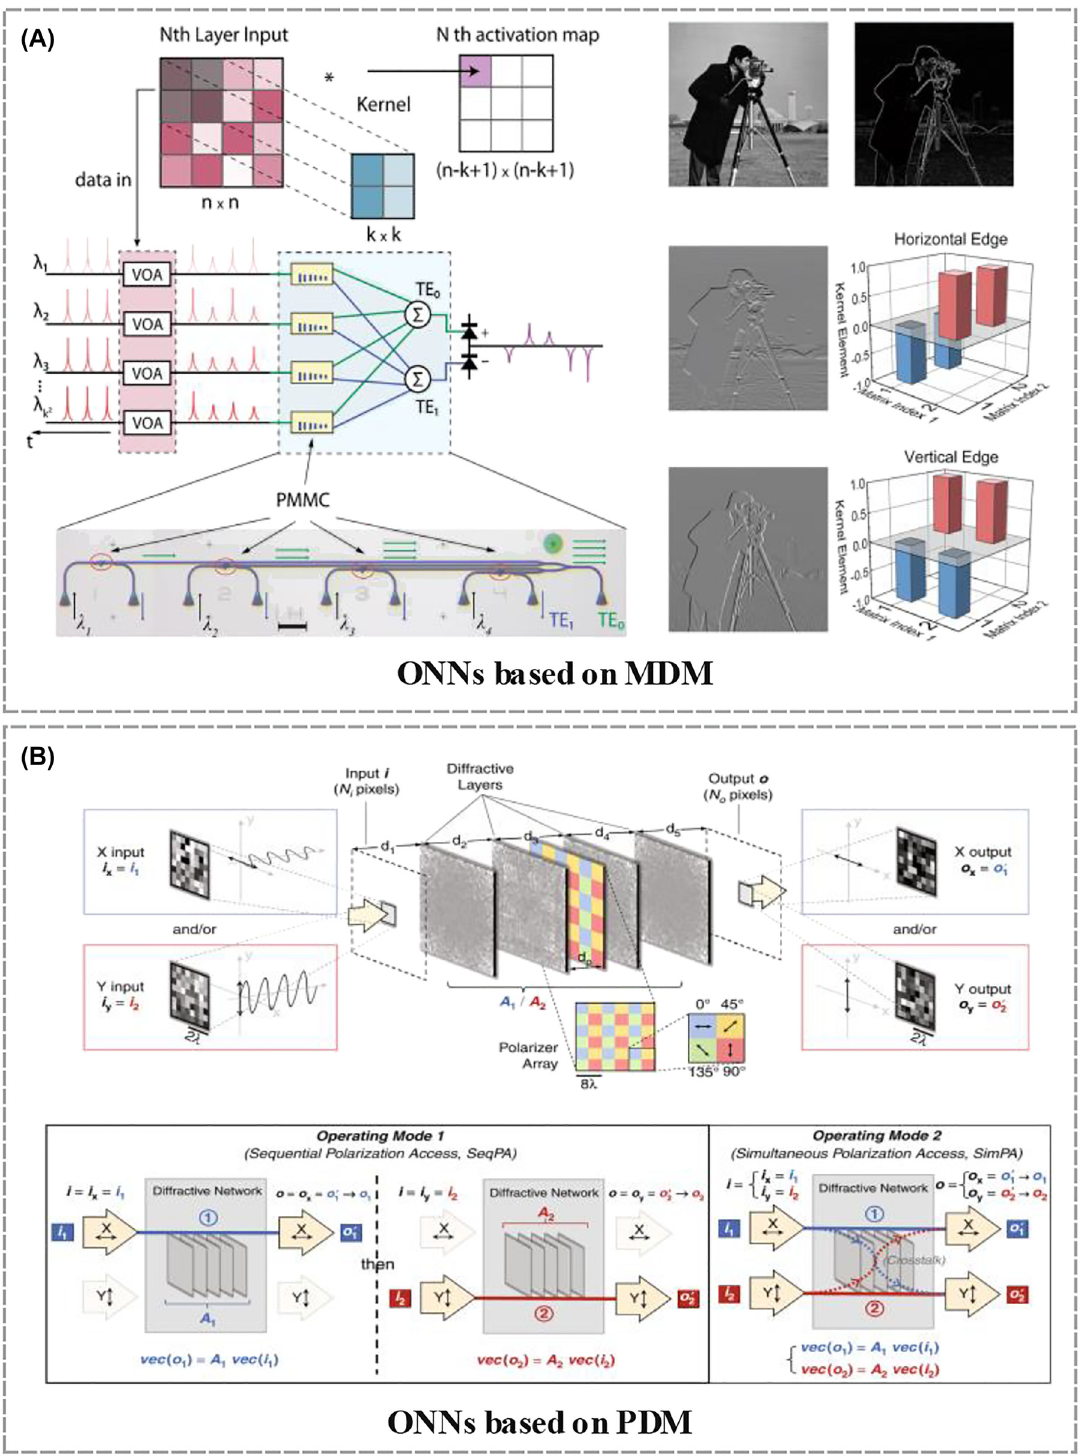
Figure 7: Advances in PDM- and MDM-based ONNs. (A) An ONN based on MDM and WDM [55]. (B) An ONN based on PDM and SDM